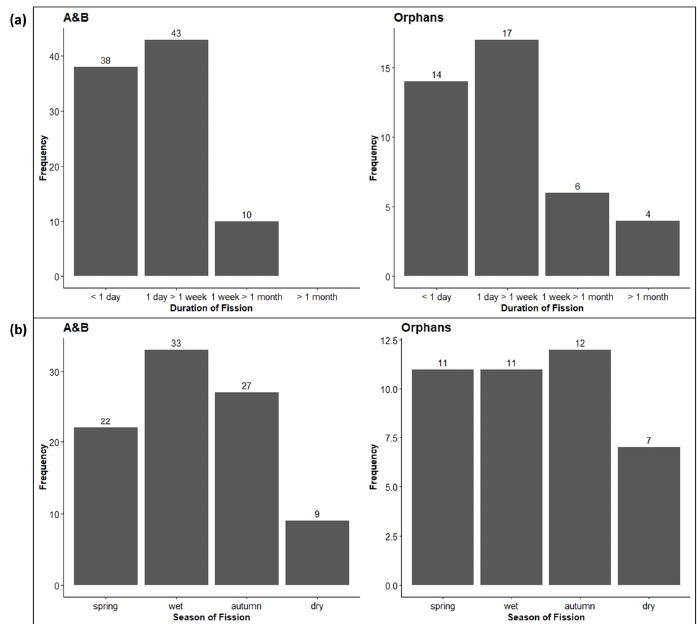
Figure 5. ( a ) The duration of fission events for the A&B herd and the Orphans. ( b ) The seasonality of fission events throughout the year. Numbers above bars indicate the number of scans in each category. Seasons: spring = September–October, wet = November–February, autumn = March–May, and dry = June–August.